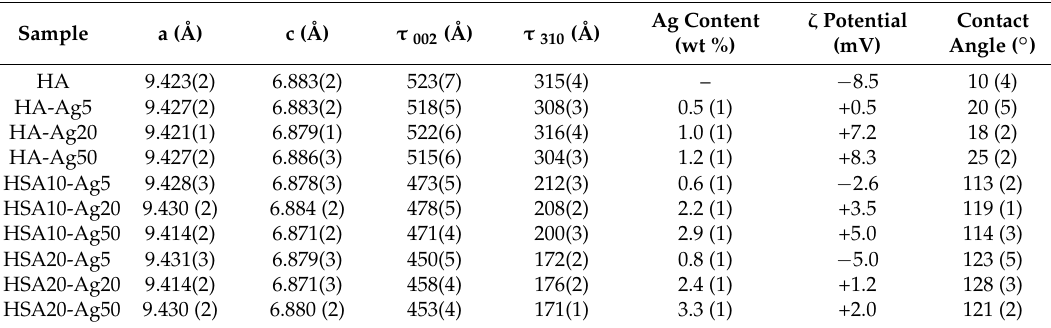
Figure 1. X-ray diffraction patterns of materials functionalized with silver nanoparticles (AgNPs): ( a ) different supports loaded in 50 mL of AgNPs suspension; ( b ) HSA20 loaded in different volumes of AgNPs; ( c ) photographs of samples. The samples are labelled HA-AgX and HSAY-AgX, where X indicates the volume (in mL) of the AgNPs suspension used for loading, and Y is the hydroxystearate concentration (in mM) in the synthesis solution. The positions of the 002 and 310 peaks of HA used for the evaluation of the crystallite size are indicated. The two orange bars indicate the positions of the two most intense reflections of silver metal (PDF 4-873). Table 1. Structural parameters, silver content and surface parameters of composite materials. Standard deviations are reported in parentheses.